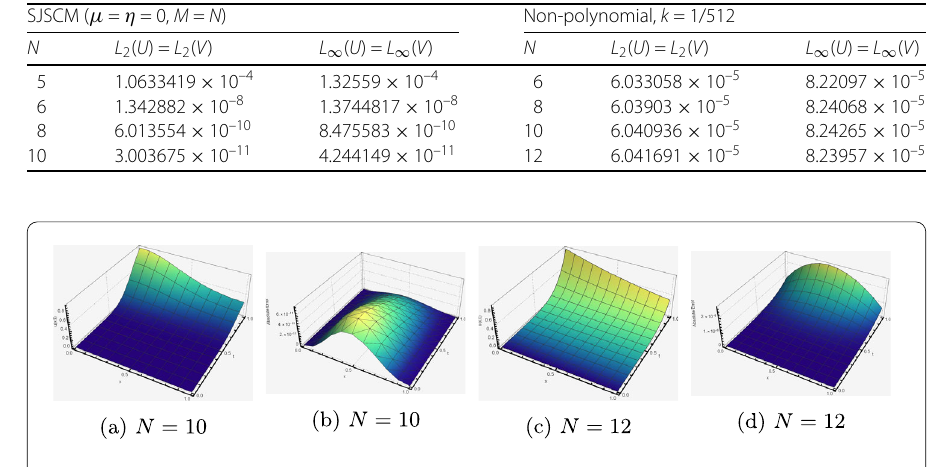
Figure 16 ( a ) and ( b ) represent approximate solution and absolute error distribution, respectively, using SJSCM. ( c ) and ( d ) represent approximate solution and absolute error distribution, respectively, using the non-polynomial B-spline method of Example 3 at α 1 = α 2 = 0.2, 0 ≤ x ≤